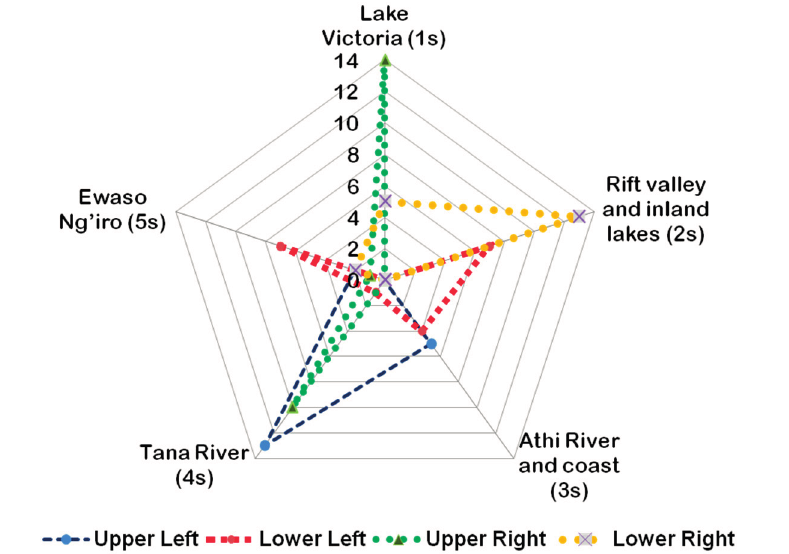
Figure 4. A radar plot illustration detailing the distribution of the sub-watersheds within the main five basins, and within the loading plot quadrants (Figure 3B). Sub-watersheds within the Lake Victoria Basin (1s) were common in the upper (UR) quadrant. Sub-watersheds in lower right (LR) quadrant were predominantly from Rift valley and inland lakes basin (2s); sub-watersheds in upper left (UL) quadrants were primarily from Tana River basin (4s) and few from Athi River and coast basin (3s); sub-watersheds in lower left (LL) quadrant were mainly from Ewaso Ng’iro (5s), and few others from Rift valley and inland lakes basin